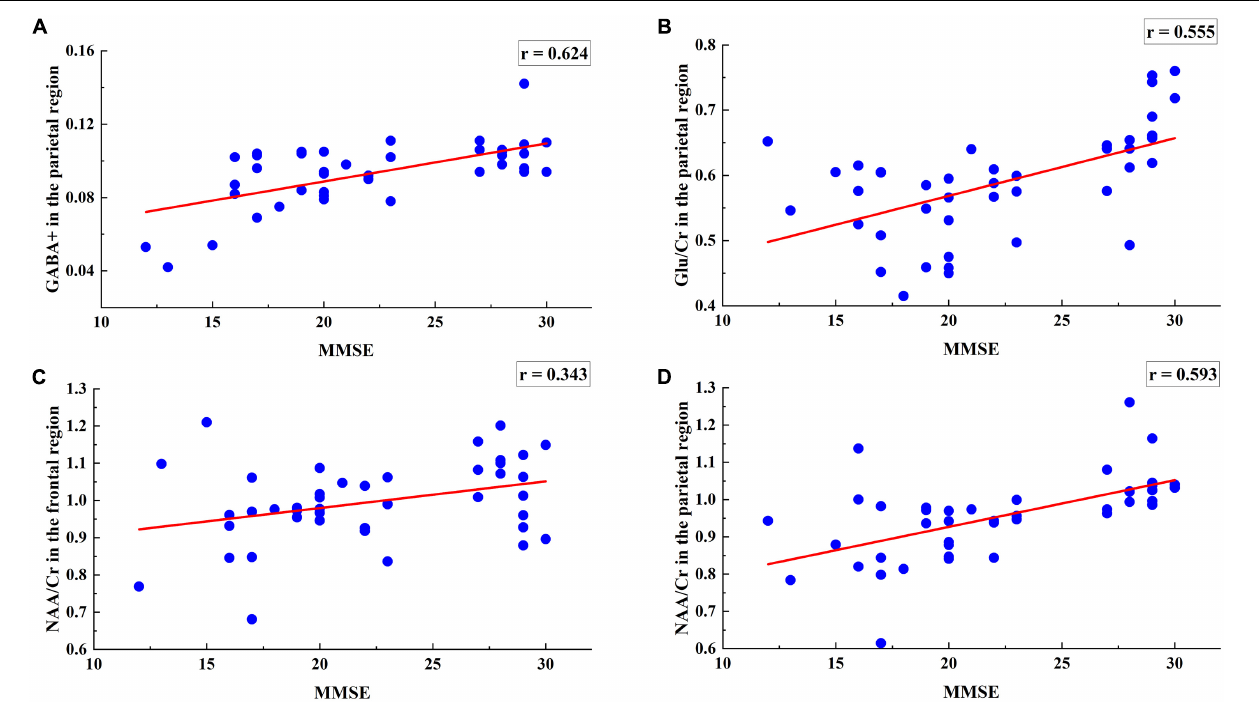
FIGURE 3 | Regression analysis of 4 metabolites including the parietal region GABA +, Glu/Cr, NAA/Cr levels and the frontal region NAA/Cr levels with MMSE. (A) MMSE scores were positively associated with the GABA + levels of the parietal region ( r = 0.624, p = 0.0165). (B) MMSE scores were positively associated with the Glu/Cr levels of the parietal region ( r = 0.095, p = 0.0068). (C) MMSE scores were negatively associated with the NAA/Cr levels of the frontal region ( r = − 0.155, p = 0.0412). (D) MMSE scores were positively associated with the NAA/Cr levels of the parietal region ( r = 0.360, p =